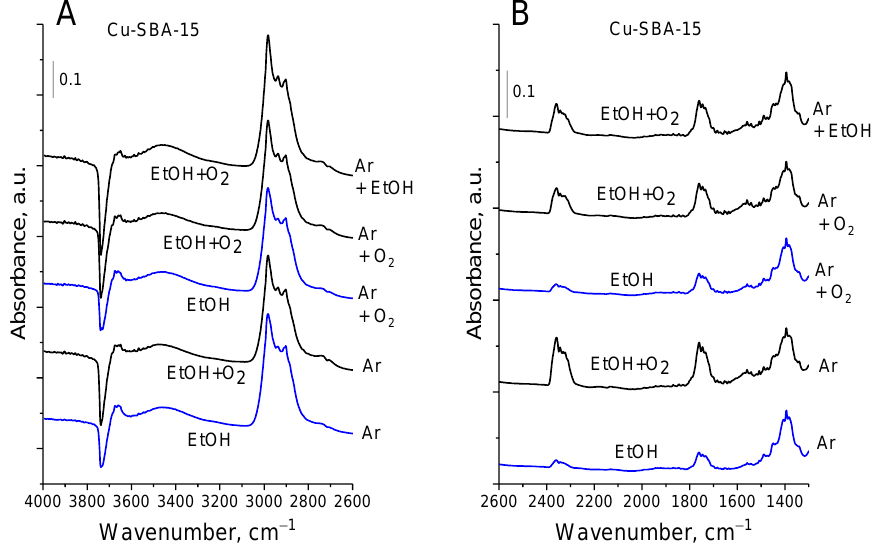
Figure 11. A comparison of the FTIR spectra recorded in ethanol (blue) and ethanol with oxygen (black) flow at 473 K after 45 min of the reaction for Cu-SBA-15 activated in Ar or Ar + O 2 or Ar + EtOH mixture: ( A ) 4000–2600 cm − 1 range; ( B ) 2600–1300 cm − 1 range.